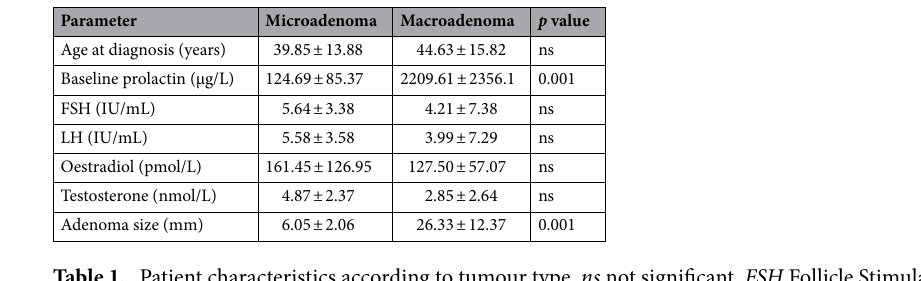
Table 1. Patient characteristics according to tumour type. ns not significant, FSH Follicle Stimulating Hormone, LH Luteinizing Hormone.